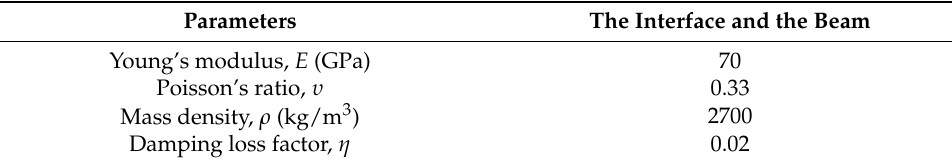
Table 2. Properties of the PZT-5A patch [35].